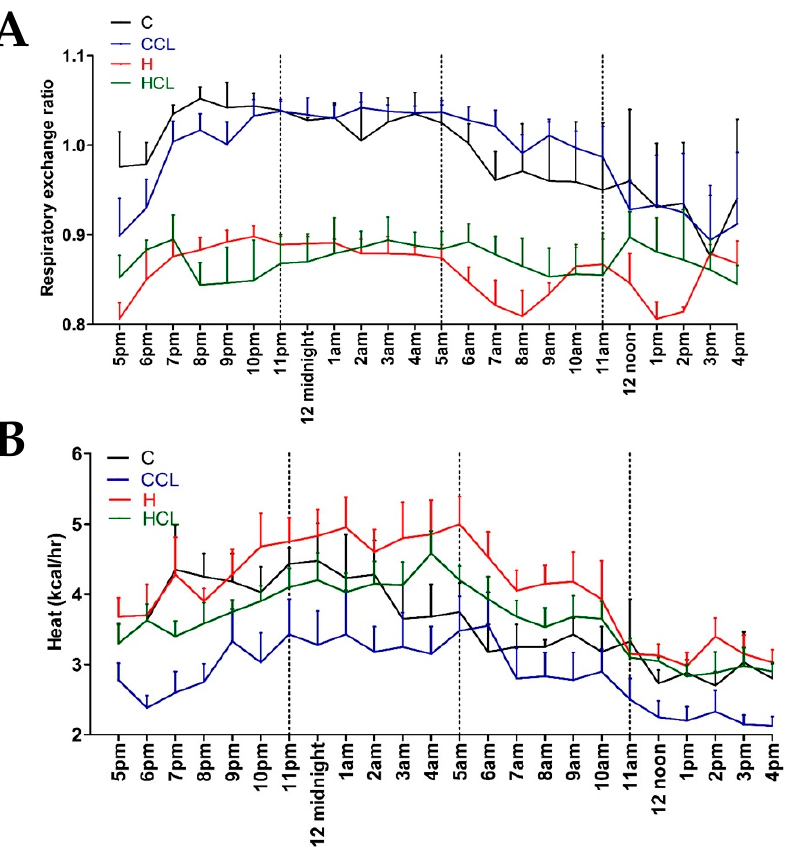
Figure 1. The 24 h indirect calorimeter Oxymax data. ( A ) Respiratory exchange ratio and ( B ) heat production in corn starch diet-fed rats (C), corn starch diet-fed rats supplemented with 5% Caulerpa lentillifera (CCL), high-carbohydrate, high-fat diet-fed rats (H) and high-carbohydrate, high-fat diet-fed rats supplemented with 5% Caulerpa lentillifera (HCL).